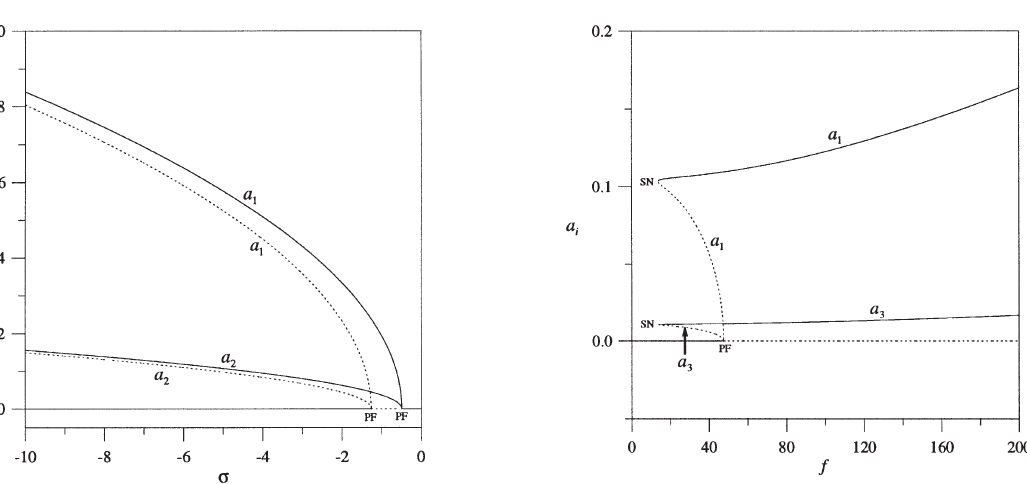
Fig. 7. Frequency-response curves for an additive-type external sub- combination resonance involving modes 1 and 2 for f = 20, (cid:22) 1 = 0 : 0137 and (cid:22) 2 = 0 : 0635. Solid lines (—) denote stable fixed points and dashed lines (– – –) denote unstable fixed points.